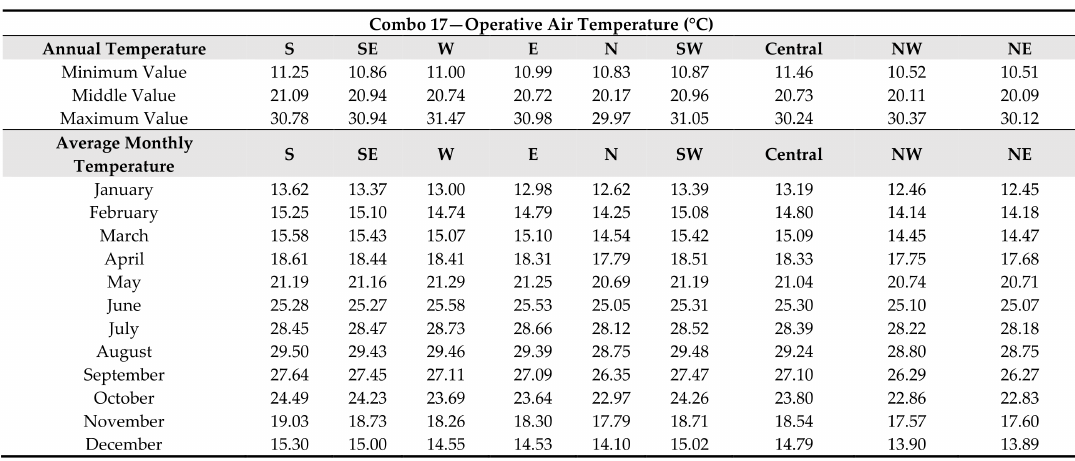
Table 13. TOP analysis for the Combo